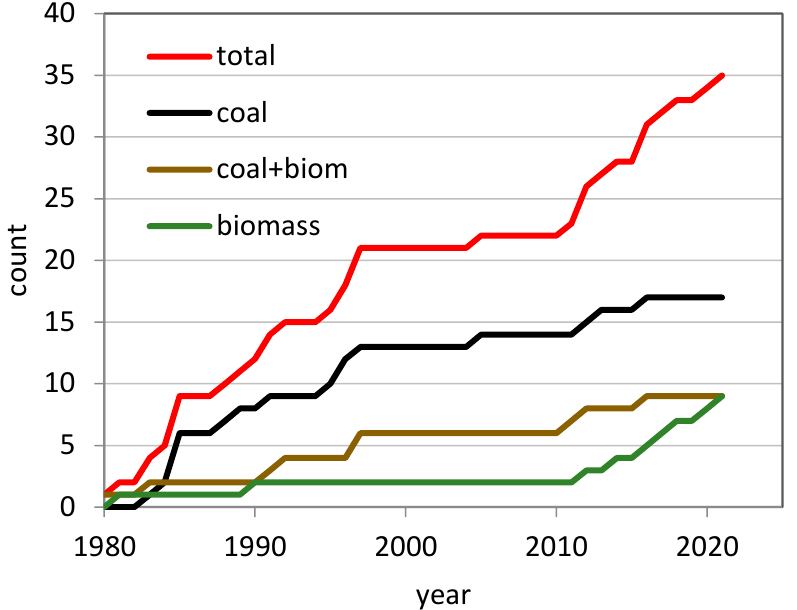
Figure 3. Evolution along the time of investigations on slurry fuels.